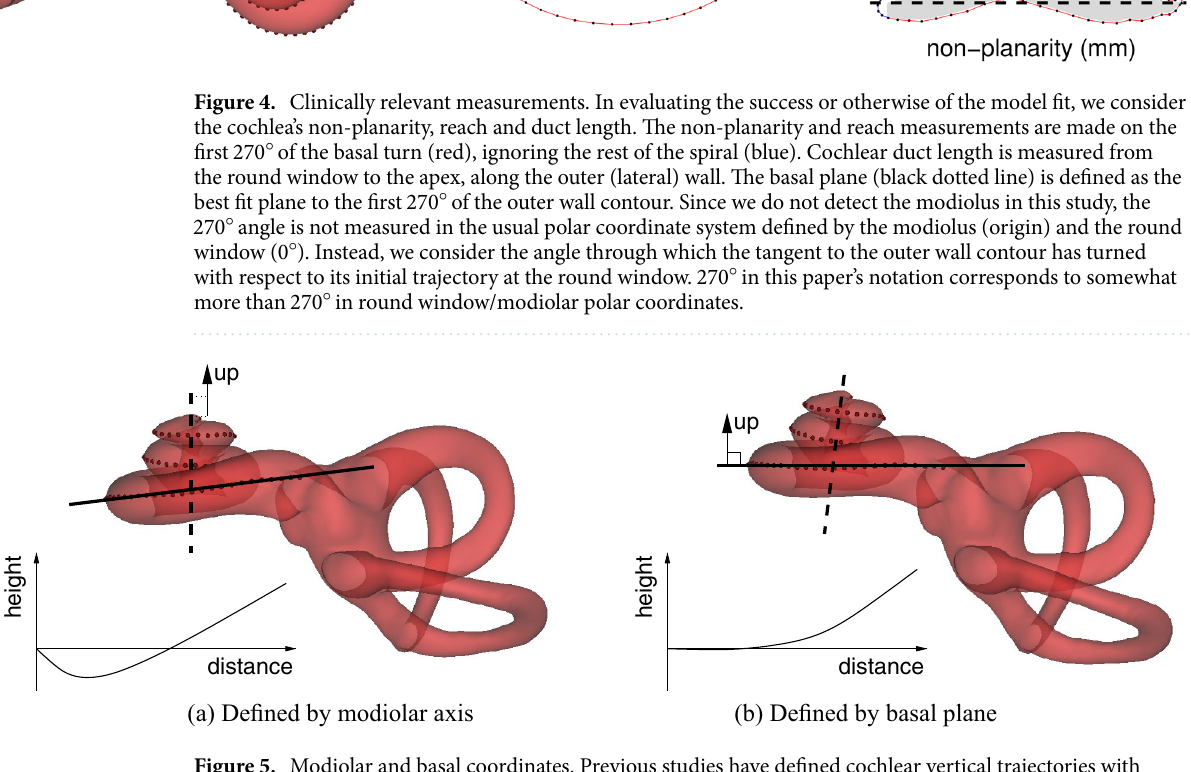
Figure 5. Modiolar and basal coordinates. Previous studies have defined cochlear vertical trajectories with reference to the modiolar axis (dashed line, a ). However, estimation of this axis is neither straightforward nor (in this context) helpful, since “rollercoaster” height profiles that go down and then up may nevertheless correspond to planar insertion trajectories that present little risk of trauma. An alternative is to replace the modiolar axis with the normal to the best fit plane through the first 270 ◦ of the basal turn (solid line, b ). In this coordinate system, the “height” axis corresponds to deviation from the best fit plane, and it is clear at which point the insertion trajectory becomes nonplanar and potentially traumatic to the cochlear